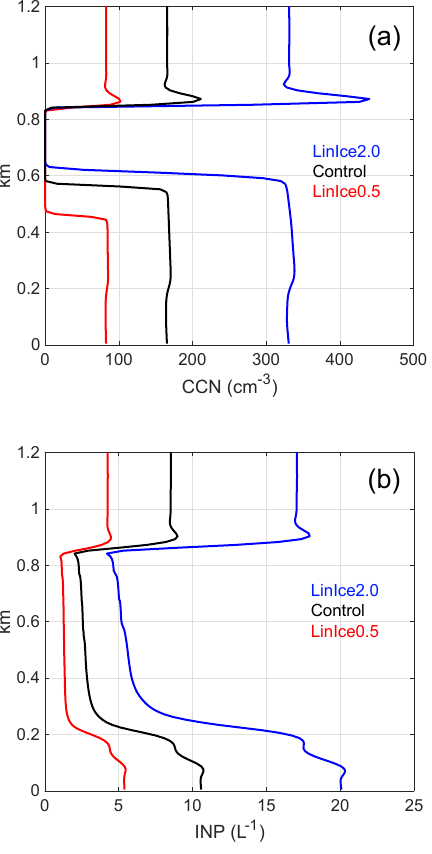
Figure 8. (a) CCN and (b) INPs in linear ice runs at hour 10, in units of cm − 3 and L − 1 , respectively. For CCN and INP factors 0.5 (red), 1.0 (black), and 2.0 (blue).